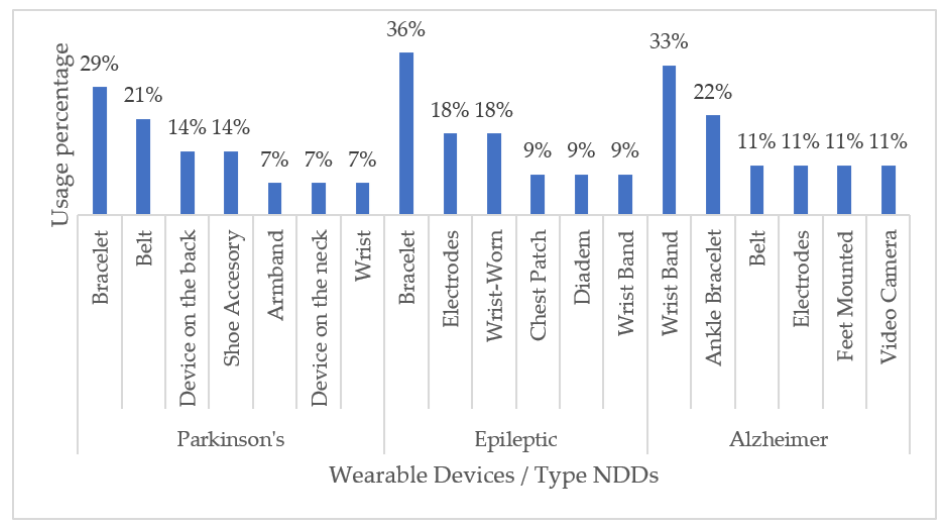
Figure 7. Non-Commercial Wearable Devices for Monitoring NDD-Related Impairments.